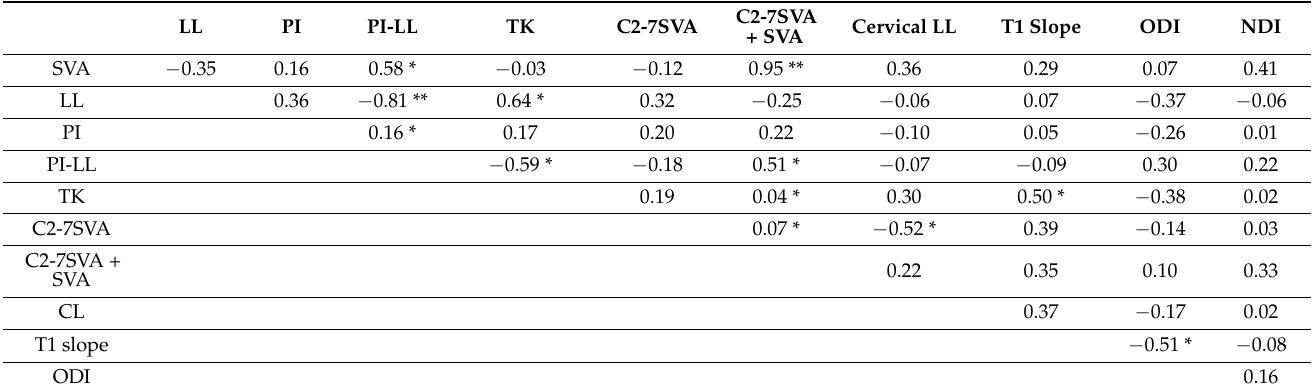
Table 3. Association among radiographic parameters using Spearman’s correlation among farmers.